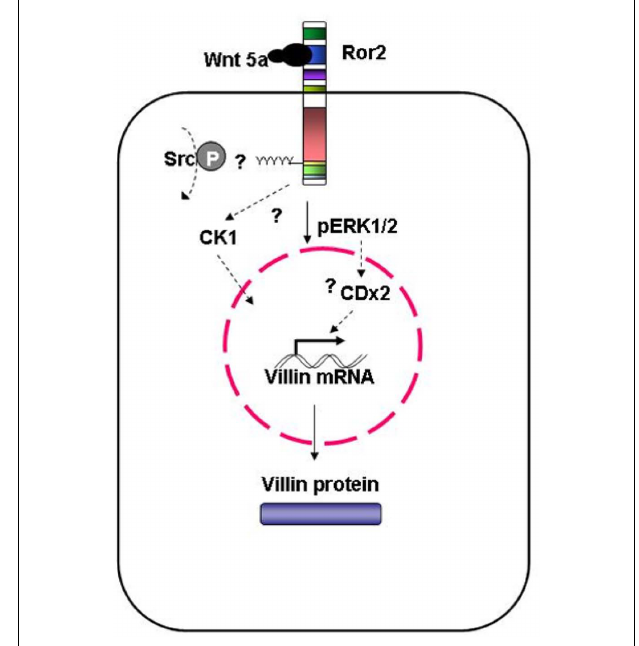
FIGURE 9 | Model ofWnt-induced villin protein expression in adenocarcinoma-derived HT29 cells and fetally derived, untransformed human intestinal epithelial cells. Wnt5a interaction with Ror2 is mediated by the cysteine-rich domain. Phosphorylation of the tyrosines within in the Ser/Thr-1 region, possibly by Src, induces ERK1/2 phosphorylation. Stimulated ERK1/2 upregulates villin transcript expression; this subsequently increases villin protein.ThisWnt5a-induced villin expression is also mediated by CK1. As well, CDX2, acting downstream of, or in parallel with, the activated ERK1/2 MAPK cascade could be mediating Wnt5a-induced increases in villin